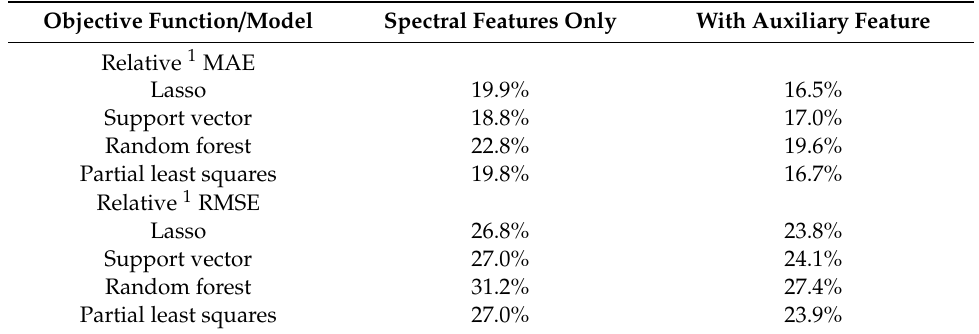
Table A2. Relative mean absolute error (MAE) and relative root mean squared error (RMSE) for each of the models evaluated in this study. The relative error values in the Spectral Features Only column used five spectral features (739, 741, 801, 867, and 873 nm), and the relative error values in the With Auxiliary Feature column used four spectral features (737, 739, 867, and 871 nm) in addition to the 10th percentile MCARI2 (Modified Chlorophyll Absorption Ratio Index Improved) before image